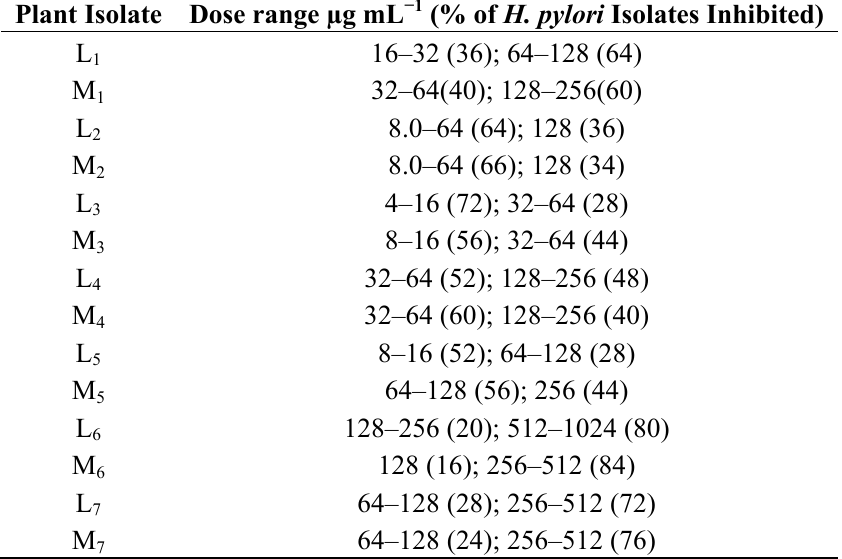
Table 3. Efficacy of plant extracts against H. pylori clinical